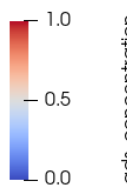
Figure 10. Adsorptive concentration on a horizontal slice through the center of the channel. Static regime ( left ), with composite cosine pulsation, at t = 7.4 s ( middle ) and t = 7.8 s ( right ).